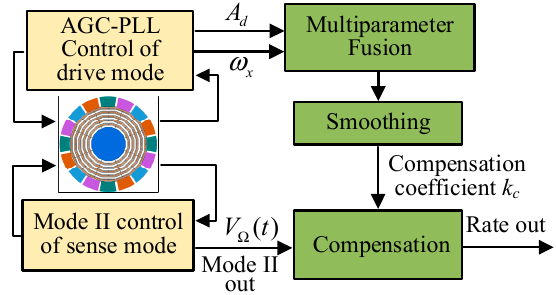
Figure 6. ZRO online compensation method.